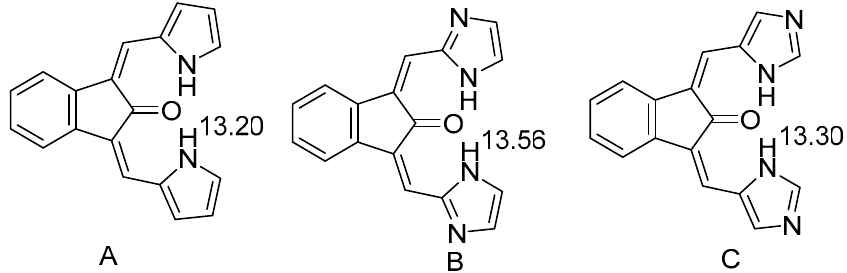
Figure 11. Bifurcated hydrogen bonds. Taken from [40]. The numbers are the NH chemical shifts in ppm.